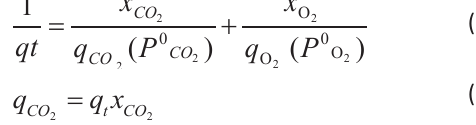
and O adsorption 2 2